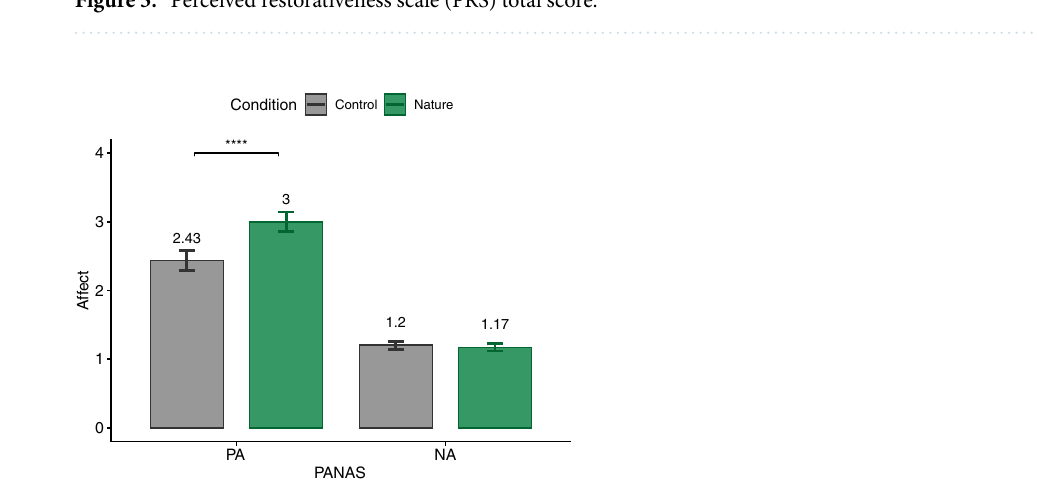
Figure 5. Perceived restorativeness scale (PRS) total score.